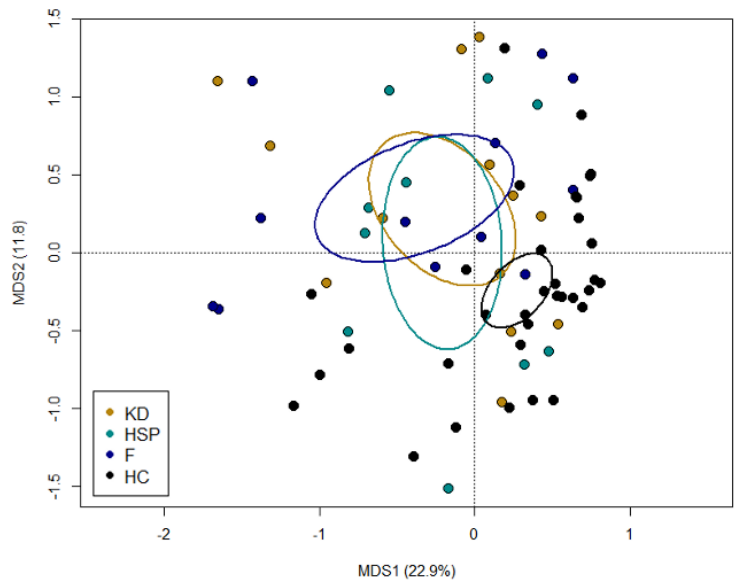
Figure 1. The gut microbiota of patients with Kawasaki disease (KD), Henoch–Schönlein purpura (HSP) and non-KD febrile illness (F) is highly variable but segregates from that of healthy children (HC). PCoA plot of beta diversity, based on Bray–Curtis dissimilarity between the genus-level profiles. A significant separation between patients and healthy controls was found ( p = 0.002, permutation test with pseudo-F ratios). Ellipses include 95% confidence area based on the standard error of the weighted average of sample